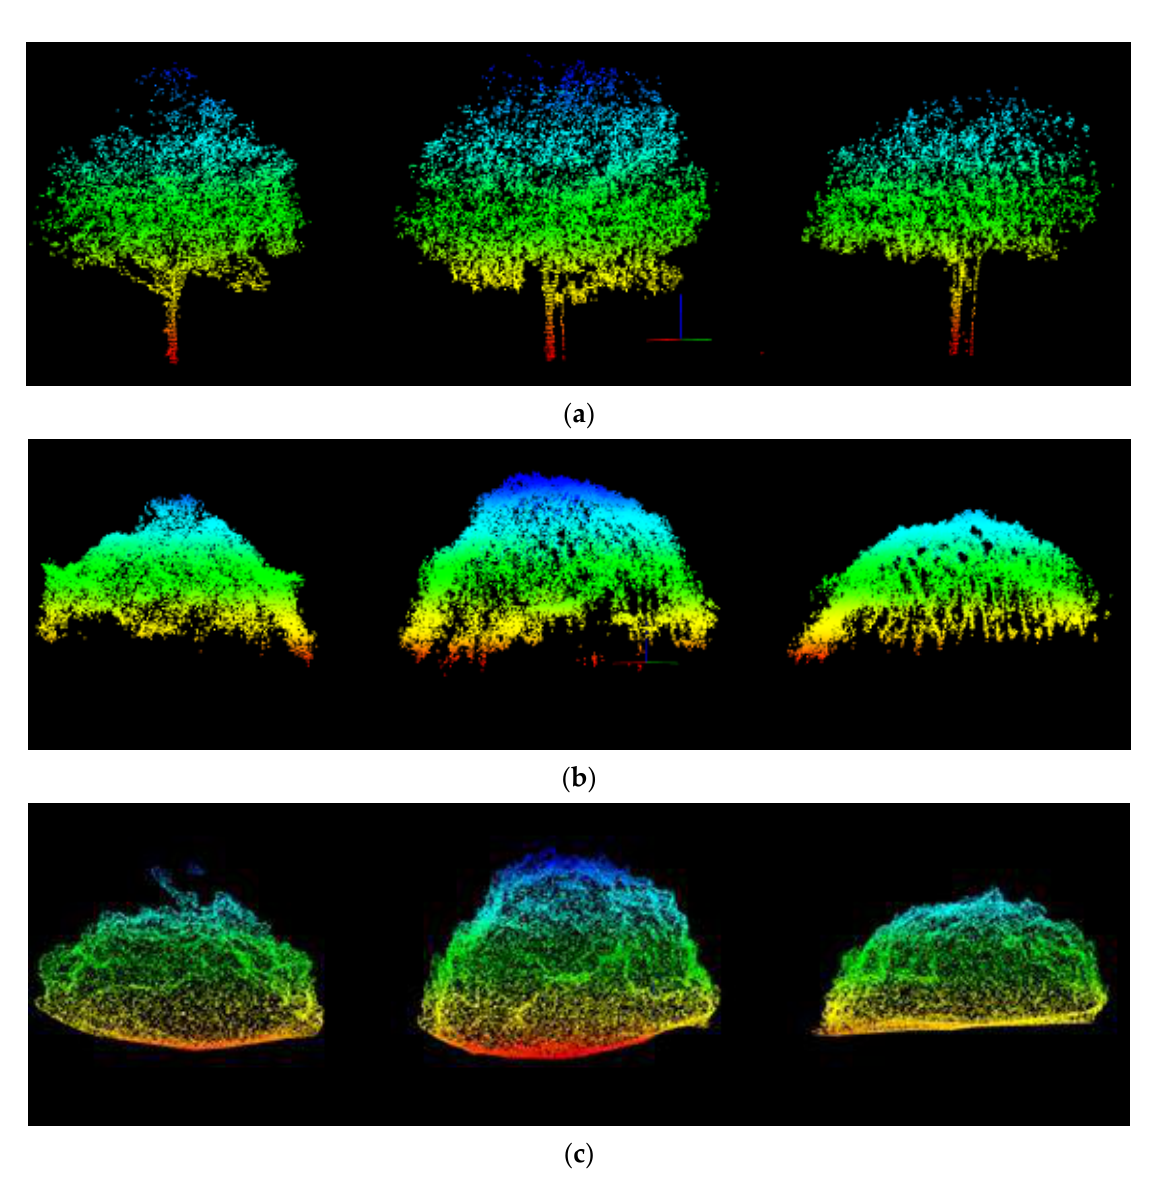
Figure 4. Vegetation point cloud data obtained through different acquisition methods. ( a ) MLS LiDAR data. ( b ) UAV airborne LiDAR data. ( c ) 3D reconstruction with UAV airborne photogrammetry images.